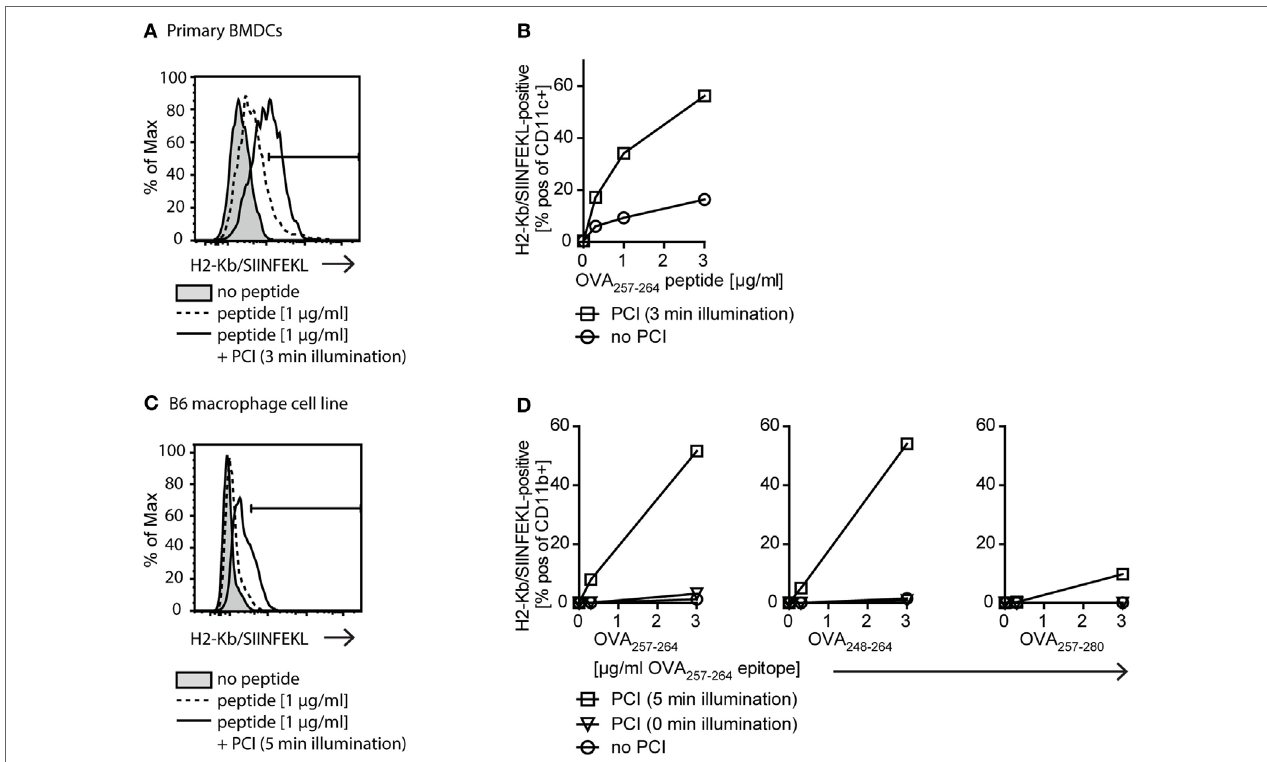
FigUre 3 | The photochemical internalization (PCI) technology enhances MHC class I antigen presentation. (a,B) Effect of PCI on MHC class I antigen presentation on primary bone marrow-derived dendritic cells (BMDCs). Cells were stimulated with 0–3 µg/ml OVA 257–264 peptide alone or delivered by PCI (0.2 µg/ml TPCS 2a , 3 min illumination). Presentation of OVA 257–264 on MHC class I (H2-Kb/SIINFEKL staining) was analyzed by flow cytometry on CD11c + BMDCs 18 h post illumination. (a) Representative example of flow cytometric analysis for stimulation of BMDCs with 1 µg/ml OVA 257–264 peptide (tinted: no peptide; dotted line: peptide alone; solid line: peptide + PCI). (B) Quantification of MHC class I presentation of OVA 257–264 peptide (H2-Kb/SIINFEKL + CD11c + cells) on primary BMDCs stimulated with 0–3 µg/ml OVA 257–264 peptide with and without PCI. (c,D) Effect of PCI on MHC class I antigen presentation on